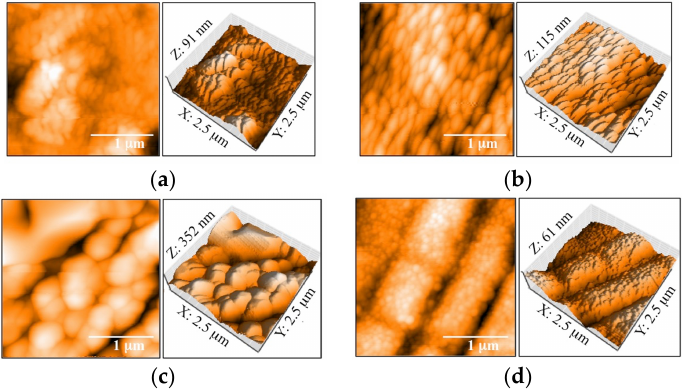
Figure 3. AFM images of CA crystals of ( a ) 600 °C ‐ 2 h, ( b ) 800 °C ‐ 2 h, ( c ) 1000 °C ‐ 2 h, and ( d ) 600 °C ‐ 4 h Y ‐ TZP disks.